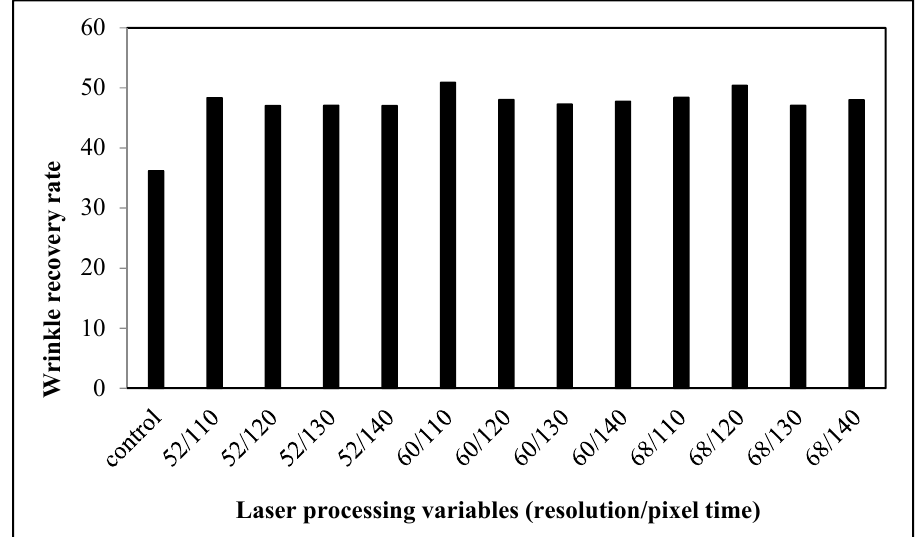
Figure 5. Relationship between laser processing variables and the wrinkle recovery rate of cotton fabric.